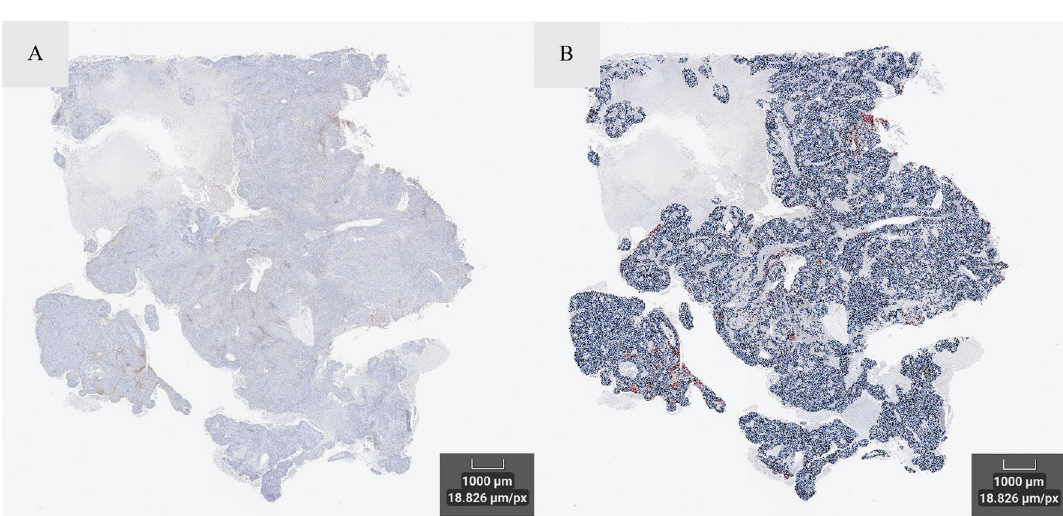
Figure 5. IA algorithm for identifying PD-L1 positive cells in whole tissue samples. Panel ( A ) shows whole tissue image of PD-L1 stained tumor. Panel ( B ) shows the same whole tissue with labeling of tumor cells in blue (PD-L1 negative tumor cells) and red (PD-L1 positive